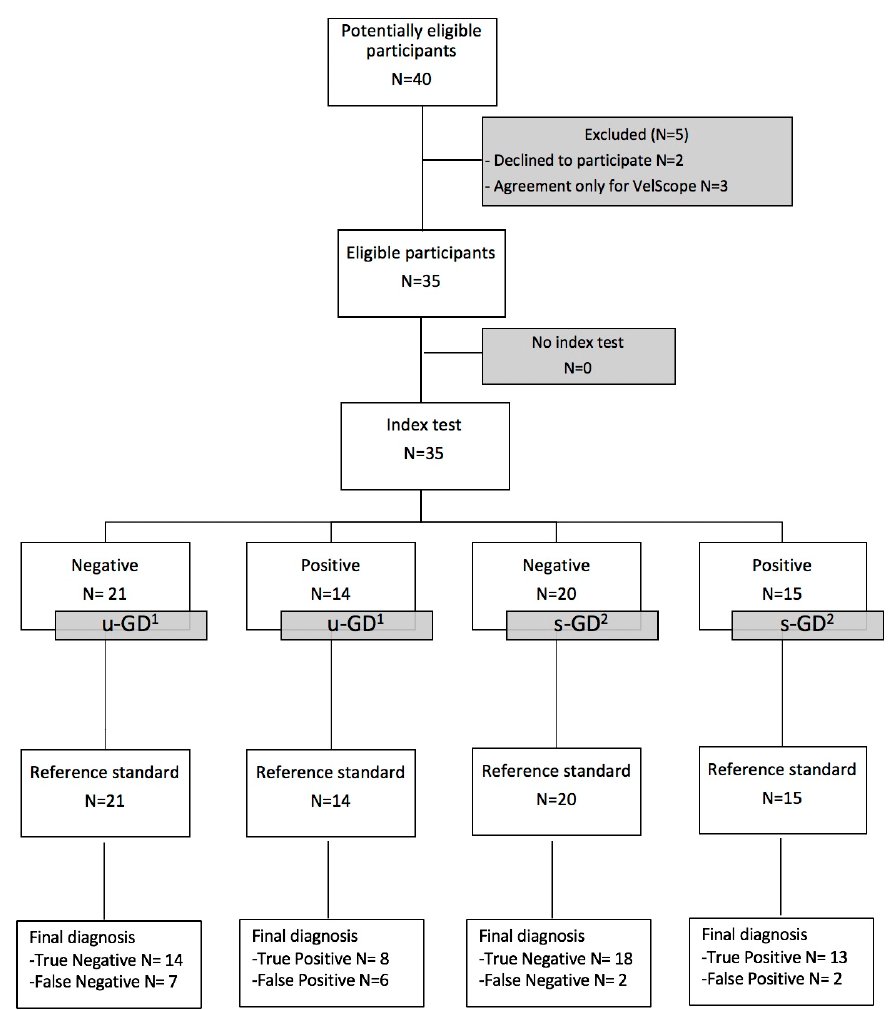
Figure 1. Flow chart of the study. 1 u-GD: unskilled general dentist; 2 s-GD: skilled general dentist.